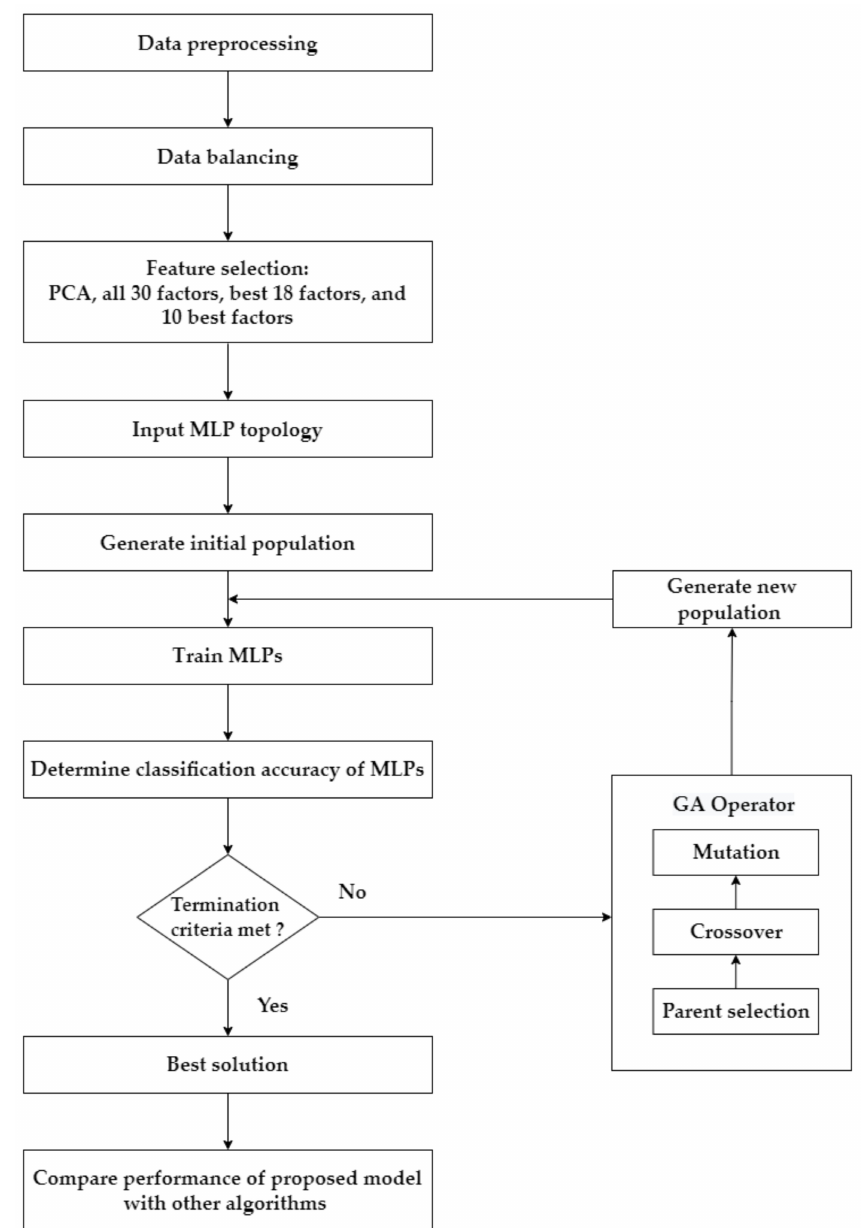
Figure 2. The framework of the proposed